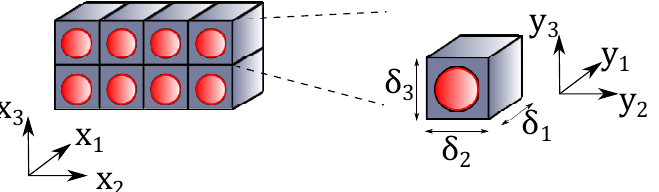
Figure 4. Representation of a periodic heterogeneous material and its RUC along with the global and local coordinate reference